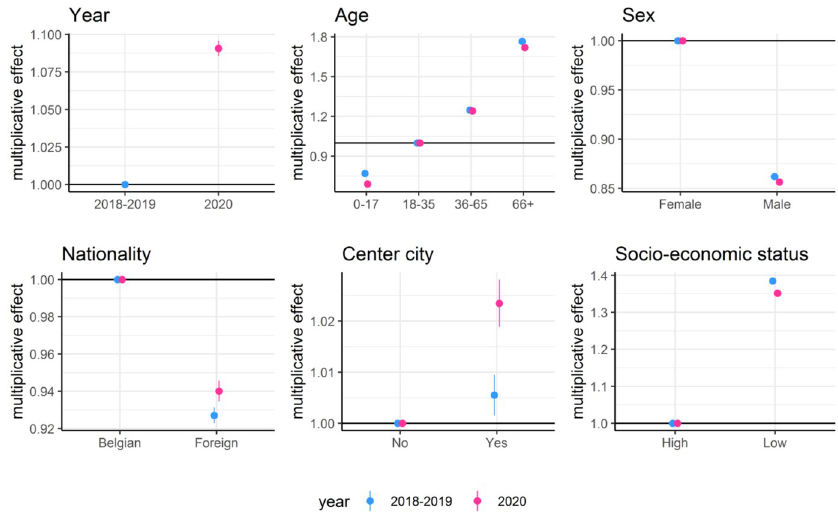
Fig 2. Multiplicative effect and associated 95% confidence intervals of covariates on the expected care provision per patient per year. Separate parameters were estimated for the period February 1, 2018 to January 31, 2020 and